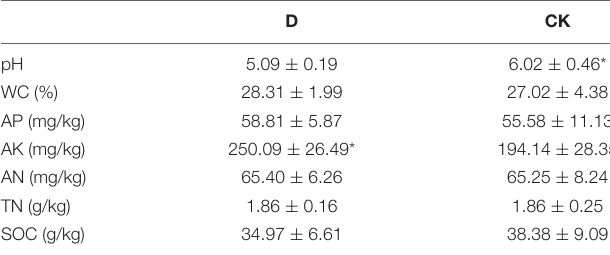
TABLE 2 | The properties of cropping obstacle soil (D) and healthy control soil (CK).